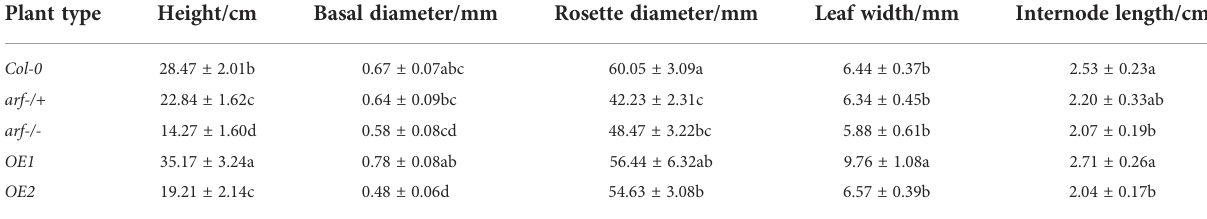
TABLE 3 Phenotypic traits of transgenic A. thaliana .